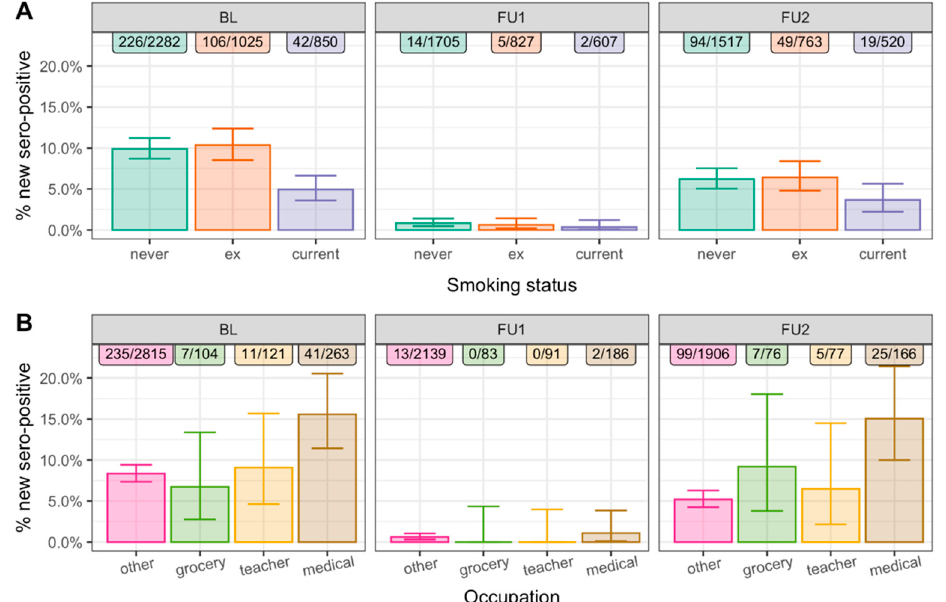
Figure 1. Proportion of N-seropositives by smoking status, occupation, and observation